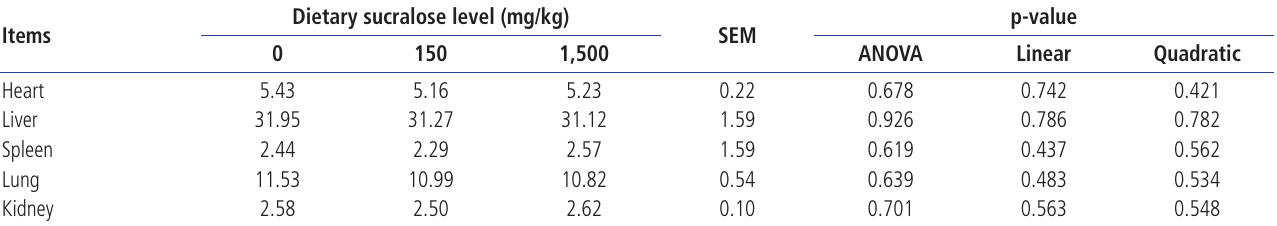
Data are the means of 6